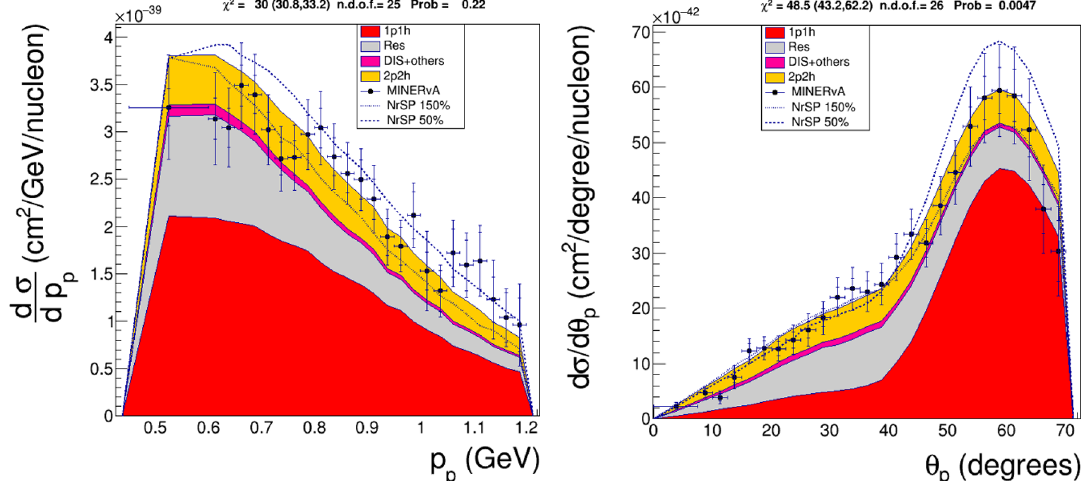
Figure 13 . MINERVA CC0 π 1p differential cross sections [15, 19, 20] in proton kinematics, mo- mentum ( | ~p ) and angle ( θ ), together with results from the current implementation of NEUT. p | p Details of the comparison with NEUT as in figure